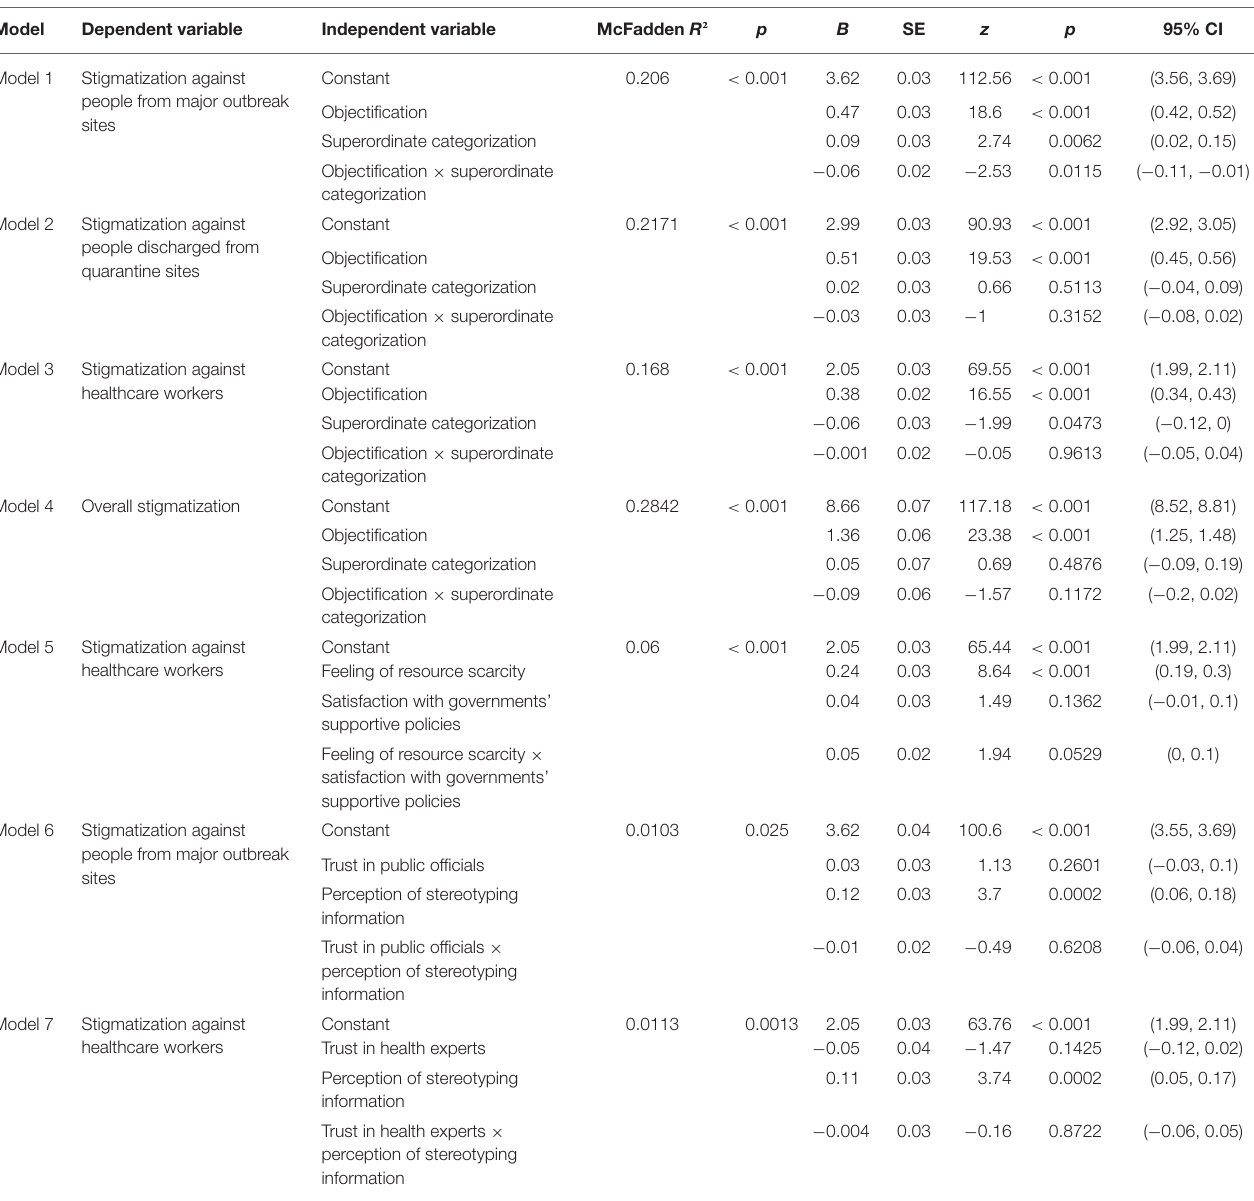
TABLE 3 | Moderation